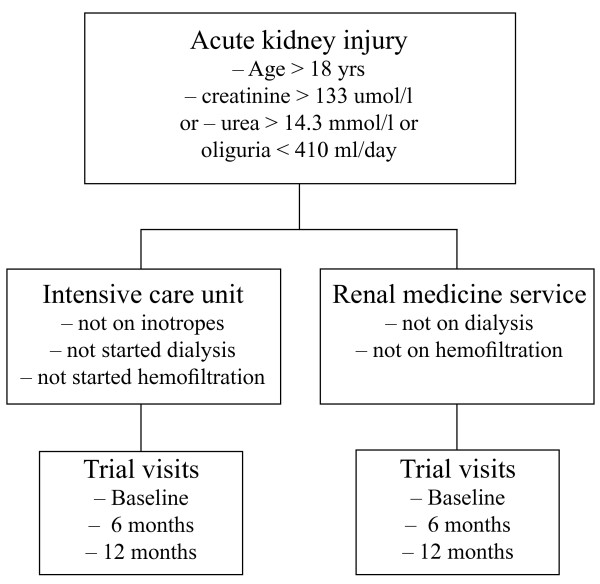
Study patient flow.